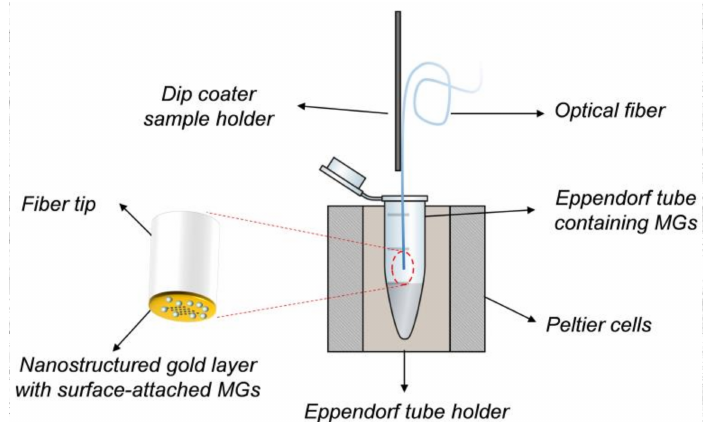
Figure 2. Schematic view of the setup used for microgels (MGs) deposition. In the zoomed image a detail on the gold nanostructure integrated on the fiber tip immersed in the MGs